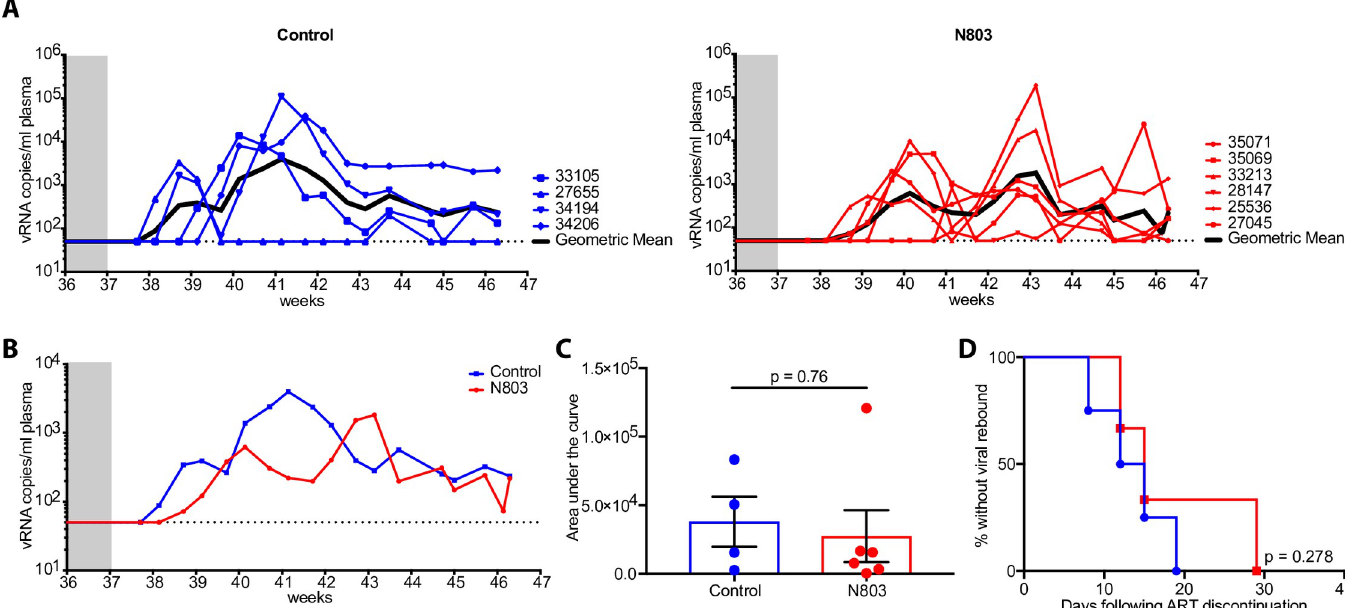
Fig 10. Animals that receive N-803 exhibit a slight delay in virus rebound after ART discontinuation. (A) Dynamics of SHIV viral load in plasma after ART release. Grey box indicates the end of ART regimen. Control group is shown on the left in blue and the N-803 group is shown on the right in red. Bold black line in each graph shows the geometric mean of each group. (B) Geometric means of both groups. (C) Area under the curve during the time of ART discontinuation to necropsy (week 37– 46.5) (D) Kaplan-Meier curve showing the percent of animals with no viral rebound. Horizontal dotted line indicates limit of detection (LOD) at 62 RNA copies/mL. P values were calculated using a Mann-Whitney test (C) , and log-rank test (D) . � , P < 0.05; �� , P < 0.01; ��� , P <